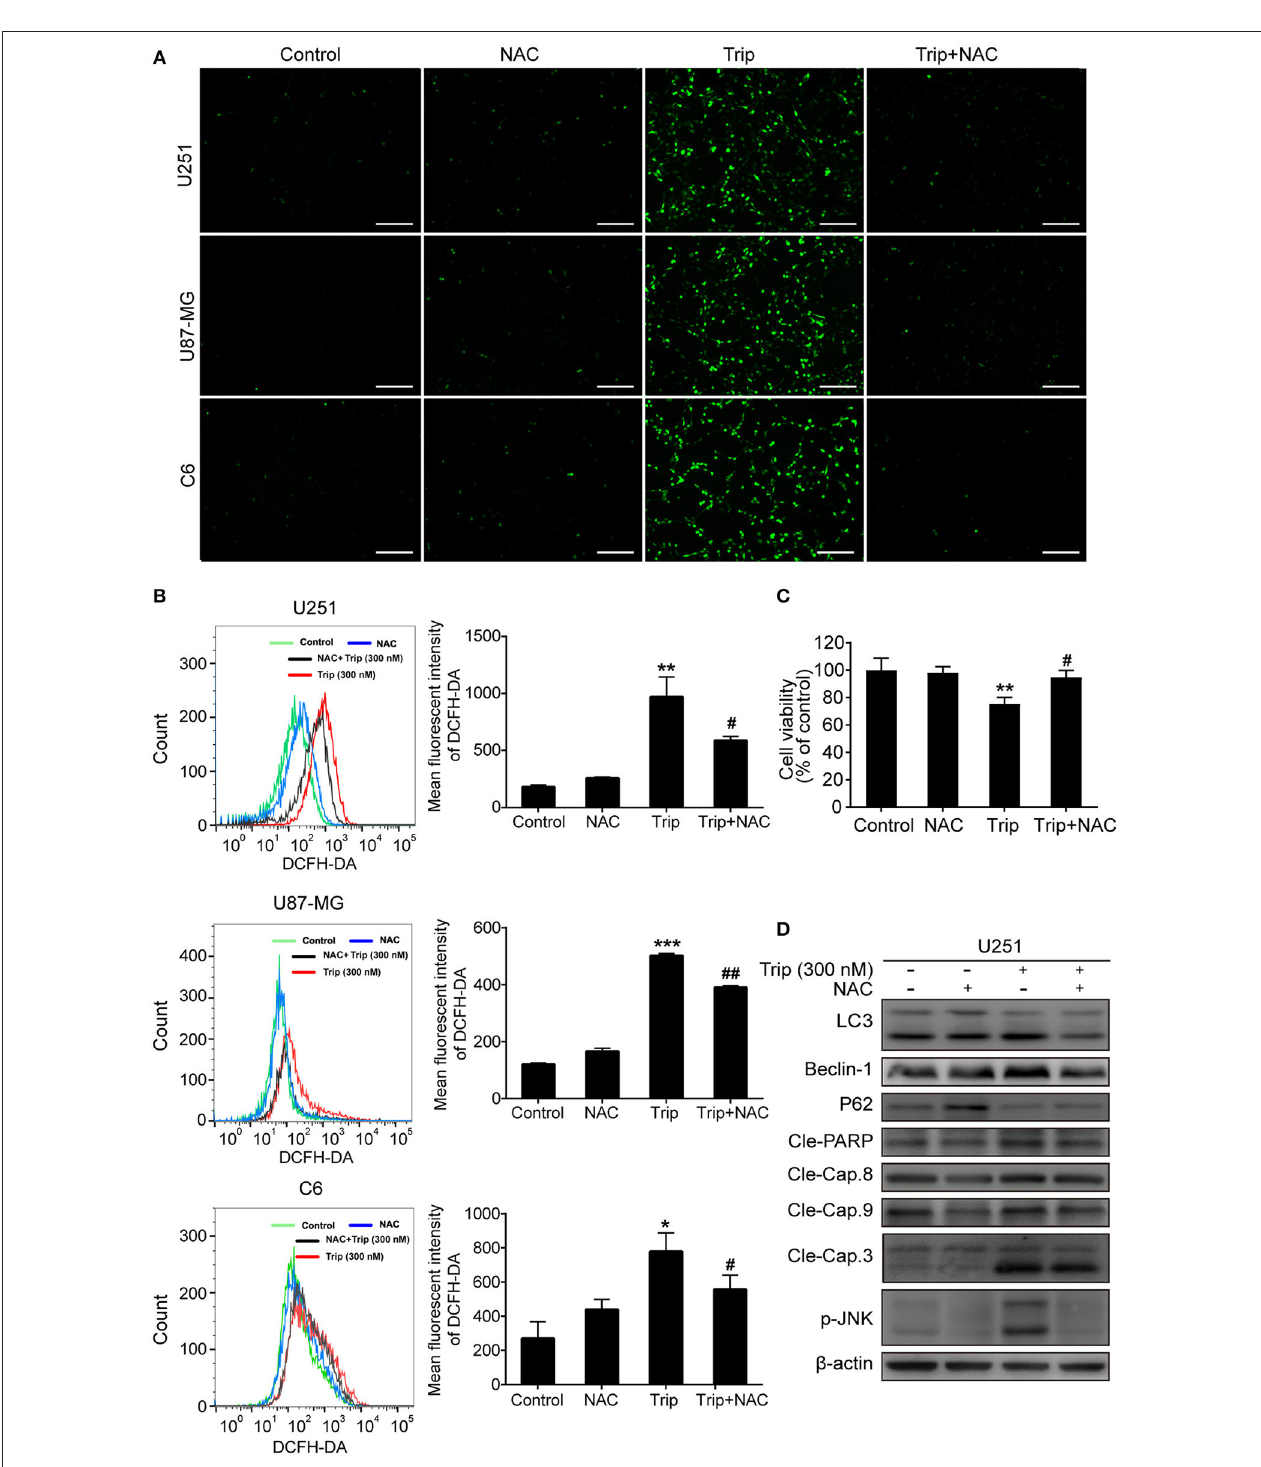
FIGURE 5 | ROS production played an essential role in triptolide-induced autophagy, apoptosis, and cell death. ( A–D) U251, U87-MG, and C6 cells were treated with triptolide (300nM) in the absence or presence of NAC (5mM) for 12h. ( A) After incubation, the cells were stained with 10 µ M DCFH-DA at 37 ◦ C in the dark for 20min and observed under a fluorescence microscope. (B) The ROS level was tested by flow cytometry, and the mean fluorescence intensity of DCFH-DA was determined. U251 cells were pretreated with NAC for 2h, followed by treatment with triptolide (300nM) for an additional 12h. ( C) The viability of the cells was measured by a CCK8 assay. ( D) Whole-cell lysates were separated by SDS-PAGE, and then, immunoblotting was performed using the indicated antibodies. Representative results from 3 independent experiments are presented. * P < 0.05, ** P < 0.01, *** P < 0.001, significantly different compared with the untreated control group. # P < 0.05, ## P < 0.01, significantly different compared with the triptolide treatment